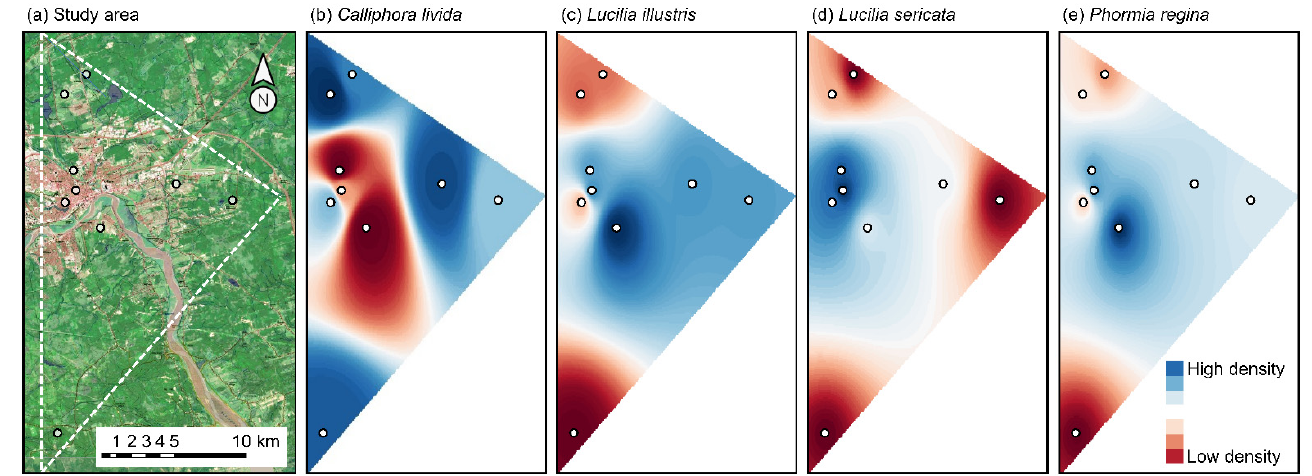
Figure 1. Map of study area ( a ) and estimated density ( b – e ) for the four most abundant Calliphoridae species during late summer 2019 in the Greater Moncton area, New Brunswick, Canada. Sampling sites are illustrated using white dots. Data used to generate this figure are a subset of a previously published study [22].